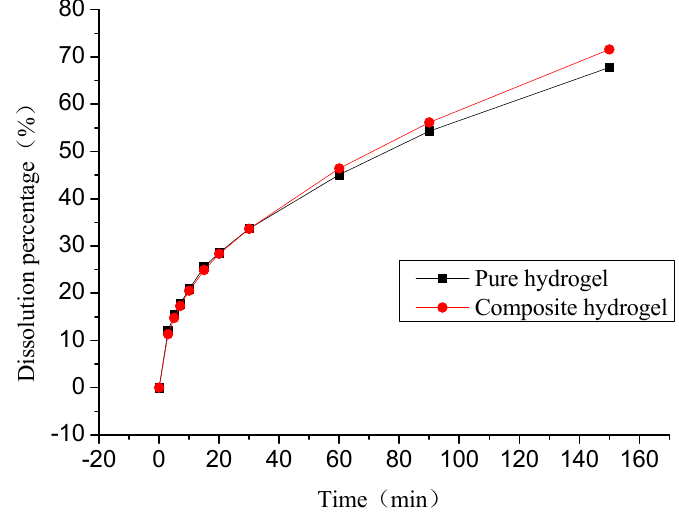
Figure 6. In vitro salicylic acid release profile of pure PVA hydrogel and PVA / FG composite hydrogel (1.5% FG) in normal saline.